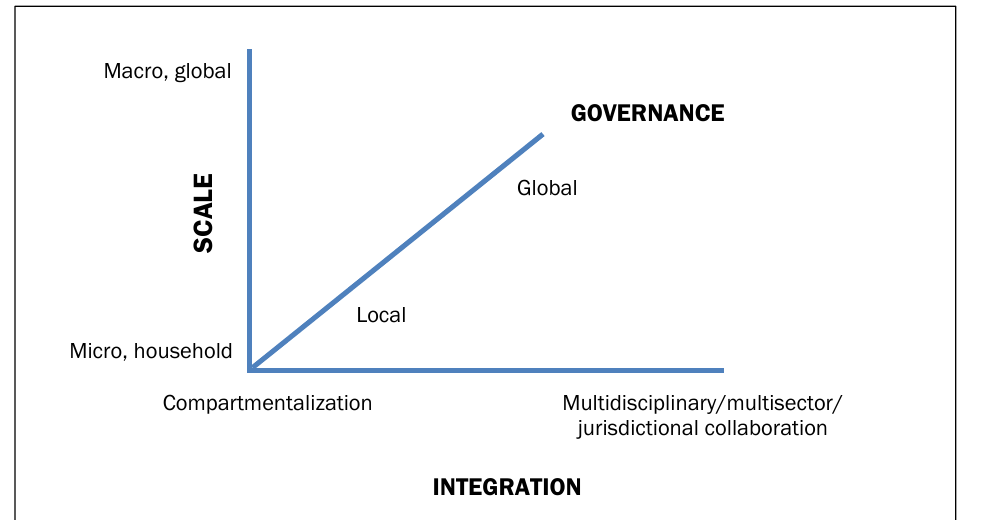
Figure 1. Continuum for Sustainable Food Systems Research